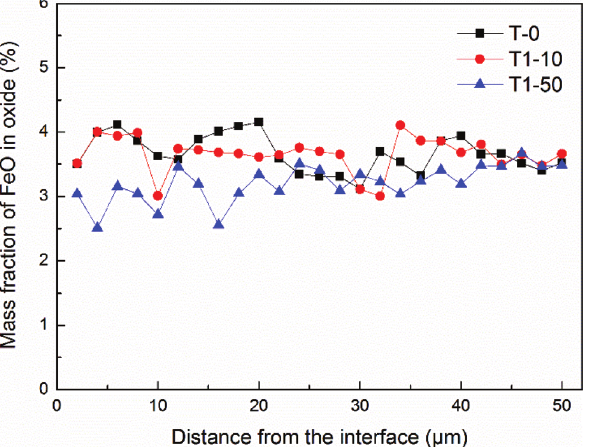
Figure 5: Concentration profiles of FeO content in the oxide near the interface after heat treatment at 1173K.